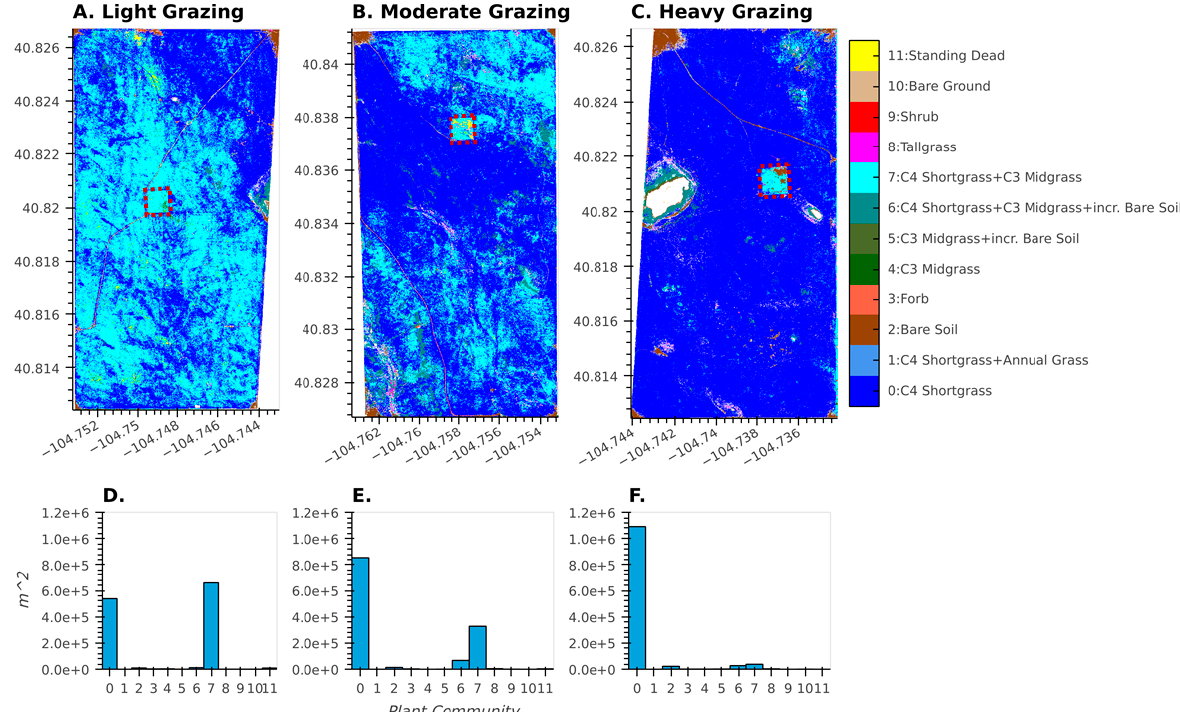
Figure 10. Results of the 2017 plant community classification across three pastures at CPER (see Figure 1) with increasing levels of grazing ( A – C ) associated with the LTGI experiment. Dotted red polygons show grazing exclosures within each pasture. Associated with each map is a histogram ( D – F ) that shows the area of each plant community class for the above pasture.